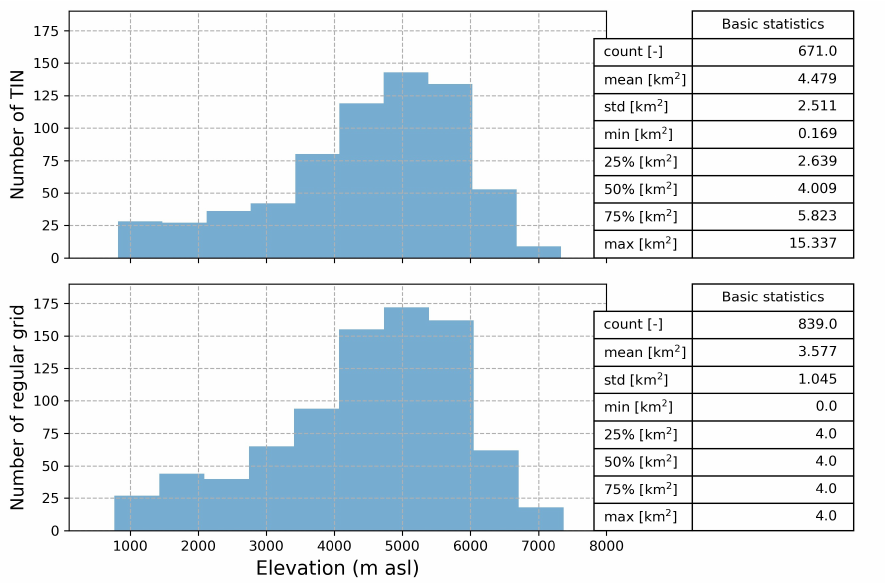
Figure 4. TIN and grid cell distribution across the elevation ranges in Marsyangadhi_2 catchment. Table 5. Hypsographical discretization and zonal characteristics. CID represents catchment number. Mean Aspect Mean Slope Mean CID